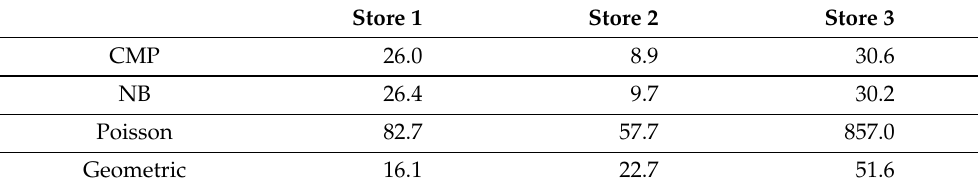
Figure 1. Estimated marginal distributions associated with the trivariate CMP (blue/square), the trivariate geometric (purple/circle), the trivariate negative binomial (red/triangle), and the trivariate Poisson (green/diamond) compared with the original data relative frequencies (histogram) regarding the number of unit sales for: ( a ) Store 1, ( b ) Store 2, ( c ) Store 3. Table 5. The goodness-of-fit test measures to compare the considered trivariate model (i.e., trivariate CMP, trivariate negative binomial (NB), trivariate Poisson, and trivariate geometric) marginal pmfs to the marginal data regarding the number of unit sales for Stores 1, 2 and 3,